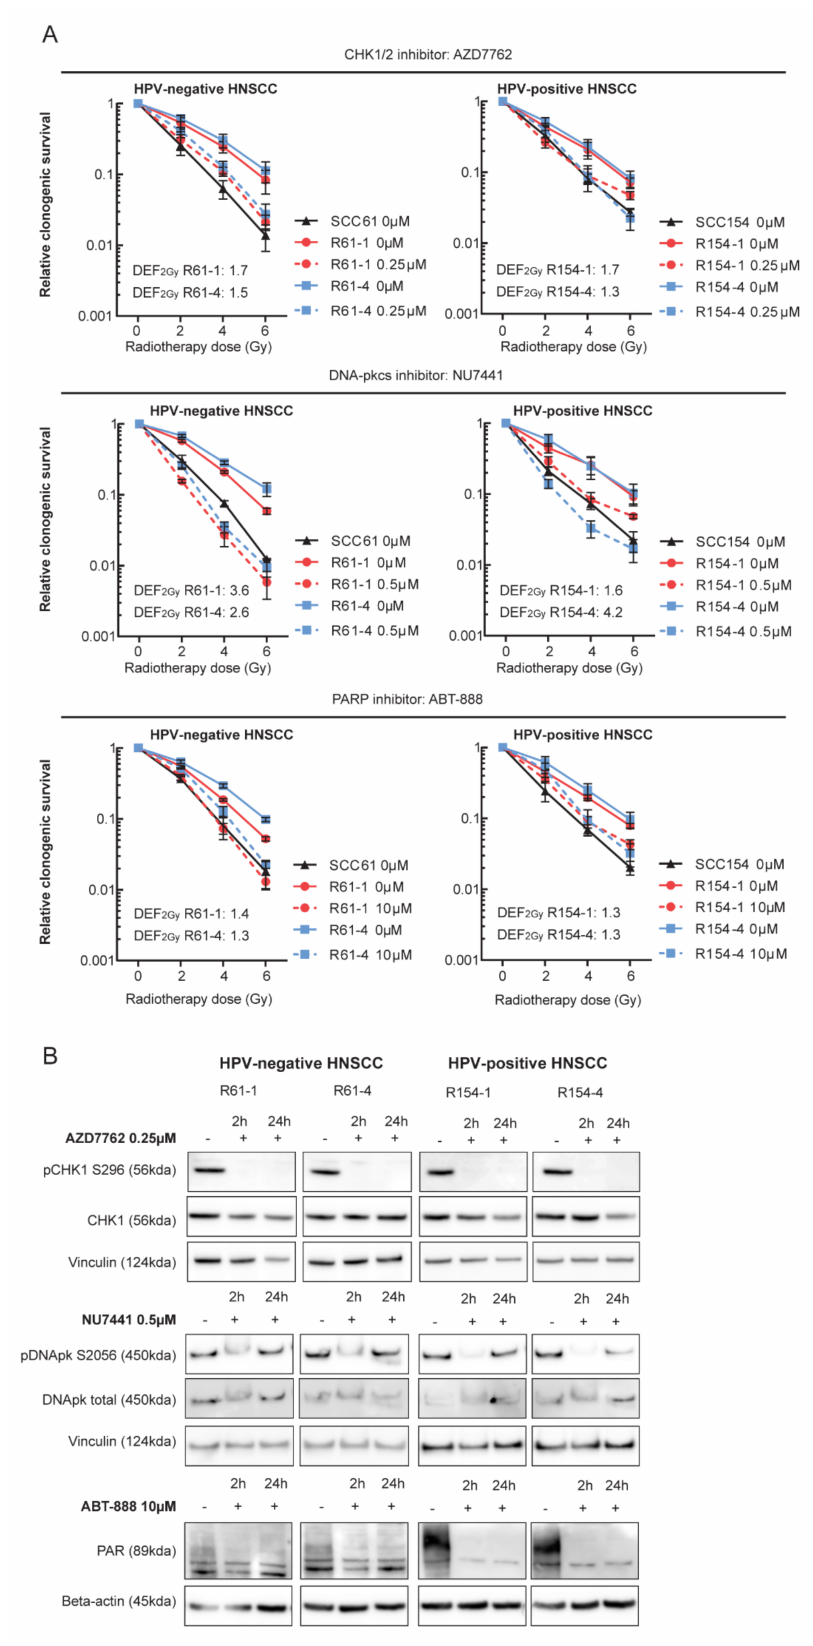
Figure 3. DDR inhibition in combination with RT radiosensitized HPV-positive and HPV-negative radioresistant HNSCC. ( A ) HPV-negative and HPV-positive radioresistant clones were pretreated